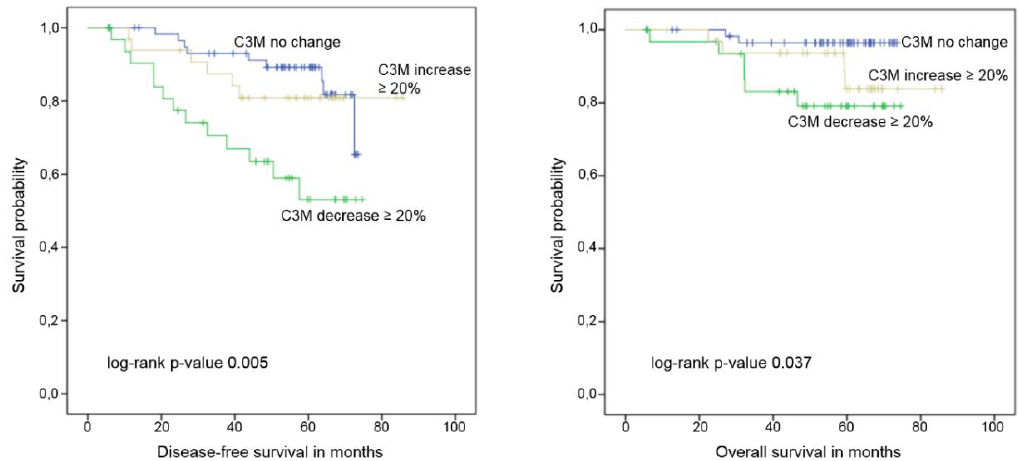
Figure 5. Kaplan–Meier plots of disease-free and overall survival stratified by changes in C3M levels between baseline and after four cycles of therapy (‘no change’ is defined as an increase or decrease <20%).